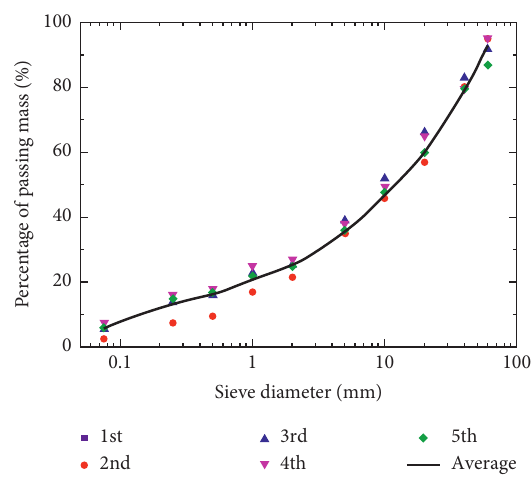
Figure 4: Particle grading curves of five